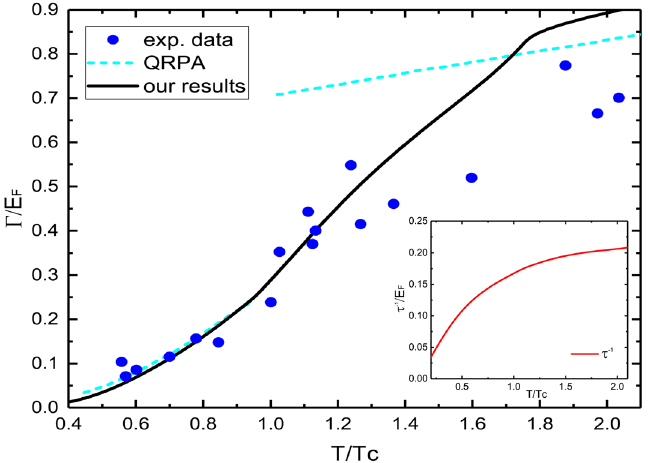
Figure 2. The damping rate Ŵ versus T / T c at unitary limit. Black solid line is our calculations. Blue circles and the cyan dashed line are experimental data and quasiparticle random phase approximation (QRPA) theory, 1 respectively, from 16 . Inset: the thermal relaxation rate τ − versus T / T c